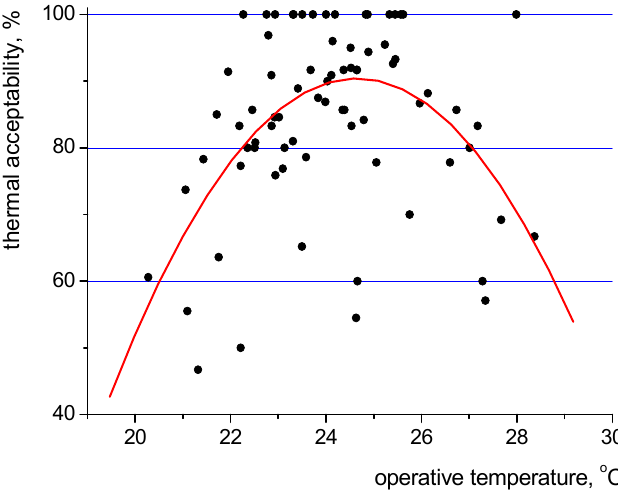
Figure 12. Relationship between average thermal acceptability and operative temperature based on 1369 questionnaires.